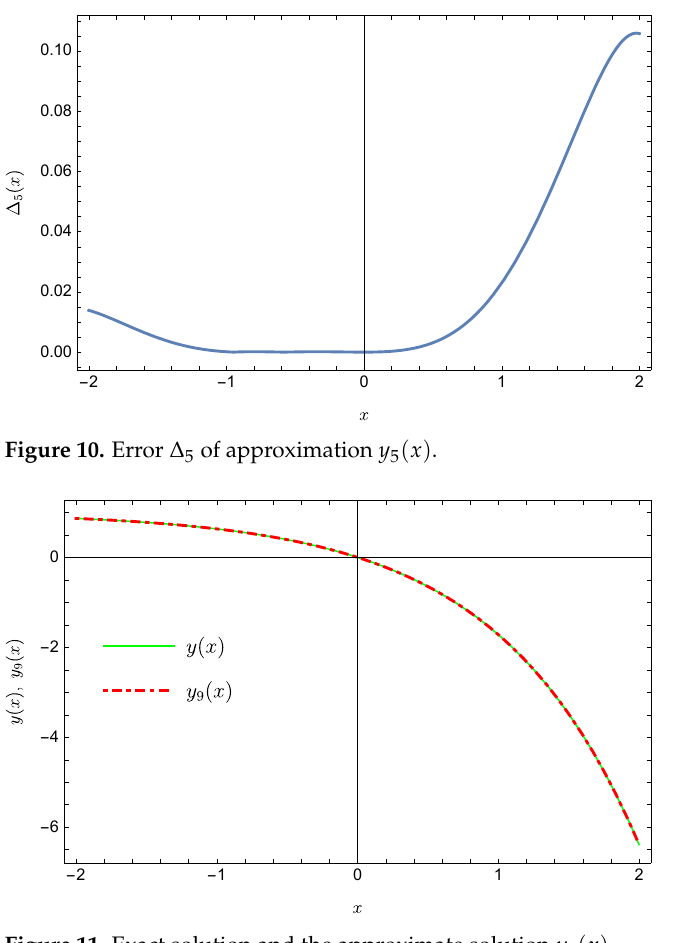
Figure 11. Exact solution and the approximate solution y 9 ( x )